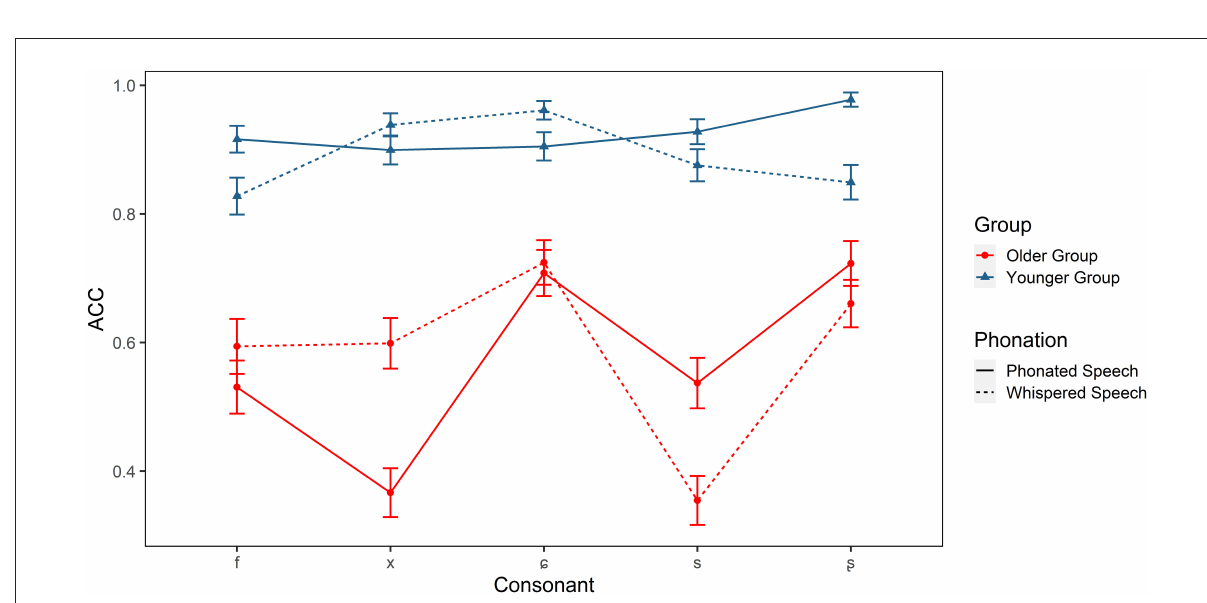
FIGURE6 Identification accuracy of the Mandarin fricatives (/f, x, C , s, ù /) in older and younger listeners.